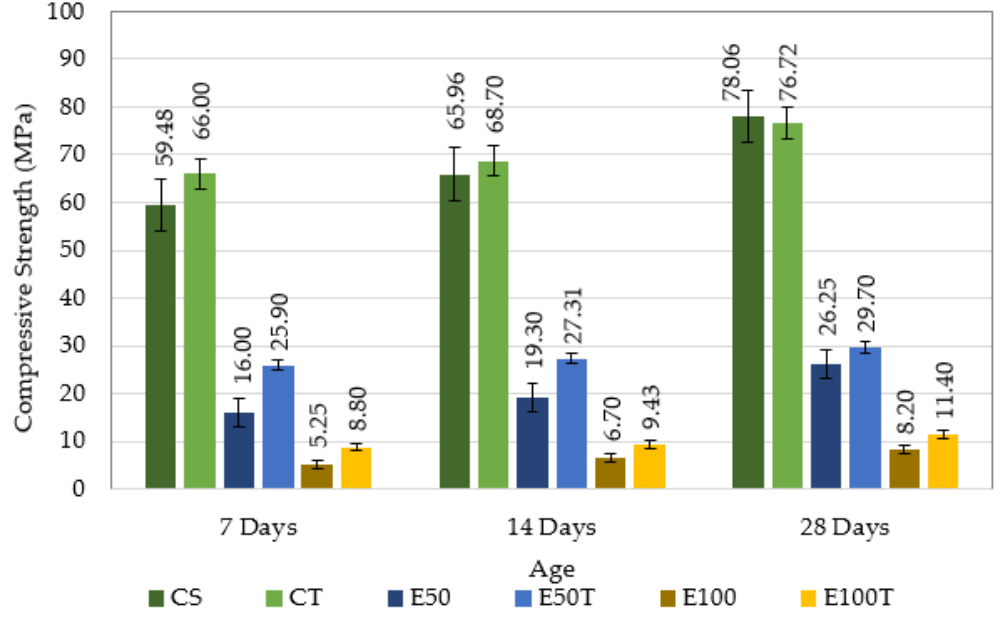
Figure 9. Compressive strength of samples at different ages.